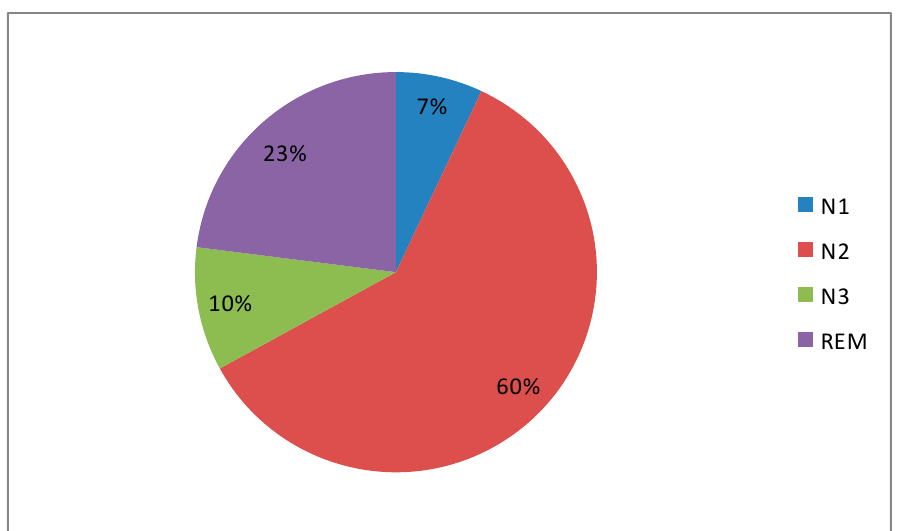
Figure 1. Periodic limb movements (PLMs) were not evaluated due to technical limitations. PSG report is presented in Table 2.